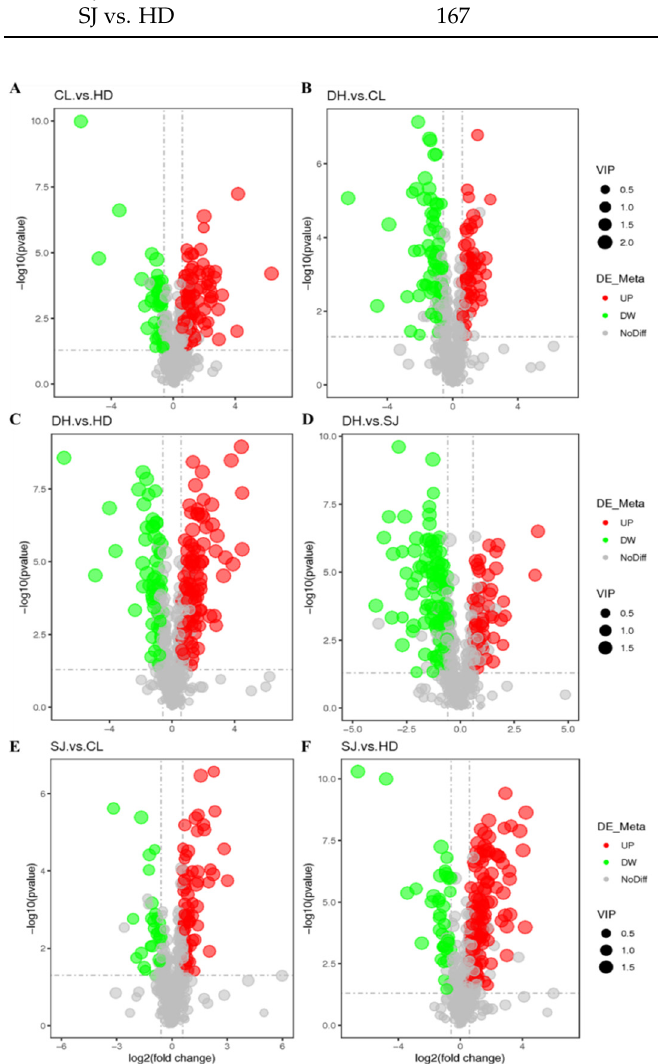
Figure 4. Volcanic map results of different groups of differential metabolites. ( A ) CL vs. HD; ( B ) CL vs. DH; ( C ) DH vs. HD; ( D ) DH vs. SJ; ( E ) SJ vs. CL; ( F ) SJ vs. HD. Daohuaxiang (DH), Huaidao No. 5 (HD), Songjing (SJ), and Changlixiang (CL). Note: UP is upregulated; DW is downward; NoDiff is no significant difference; the abscissa represents the change in difference multiples, and the ordinate represents the level of difference visibility. Table 1. Quantitative identification of differential metabolites.